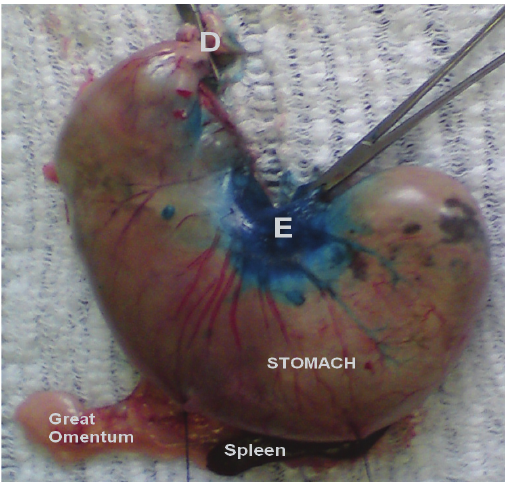
FIGURE 2 - Photograph demonstrating the surgical part resected in block. E =Esophagus; D =Duodenum.